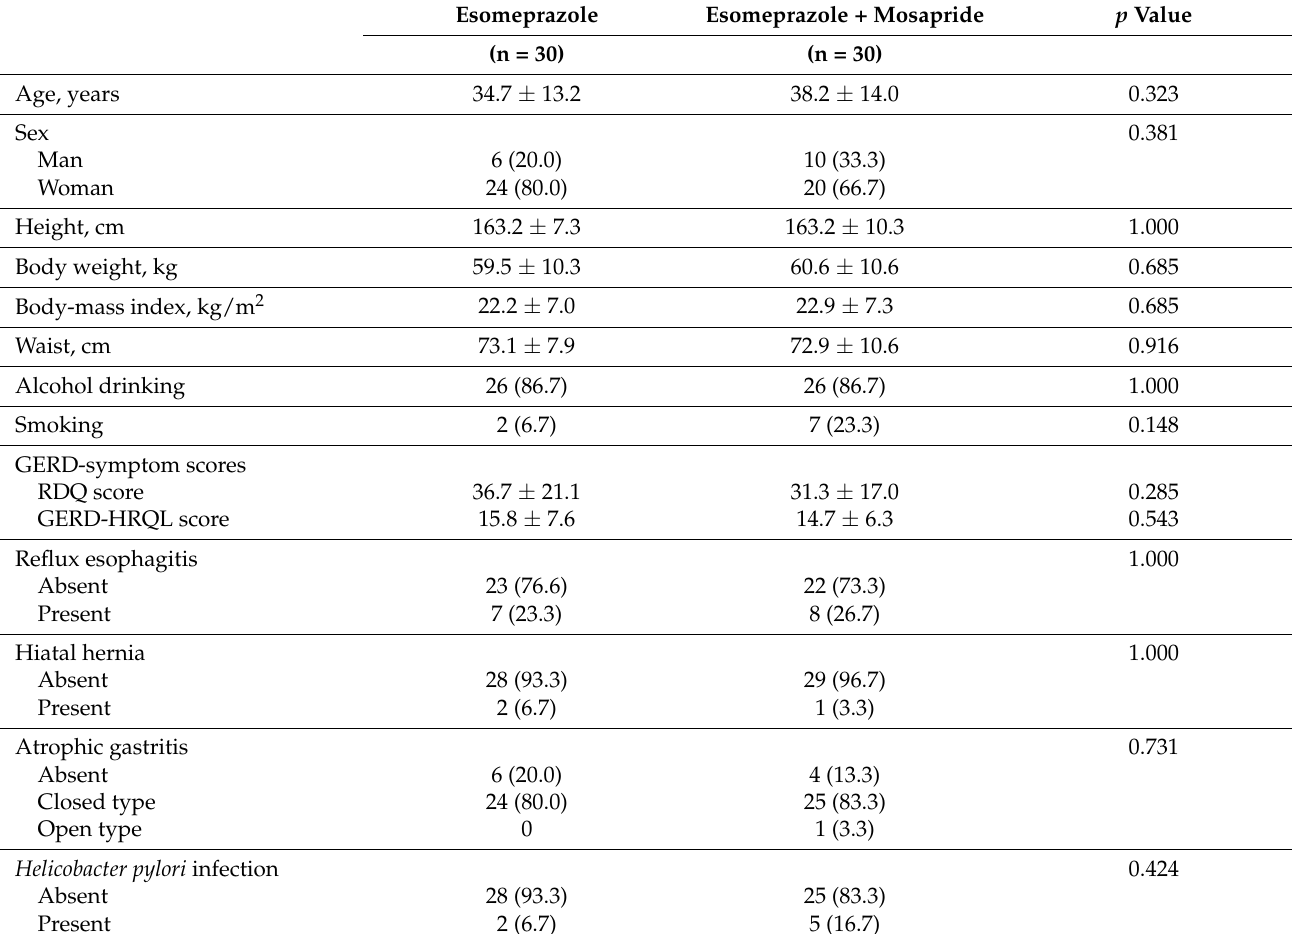
Table 1. Baseline clinicodemographic characteristics of the study